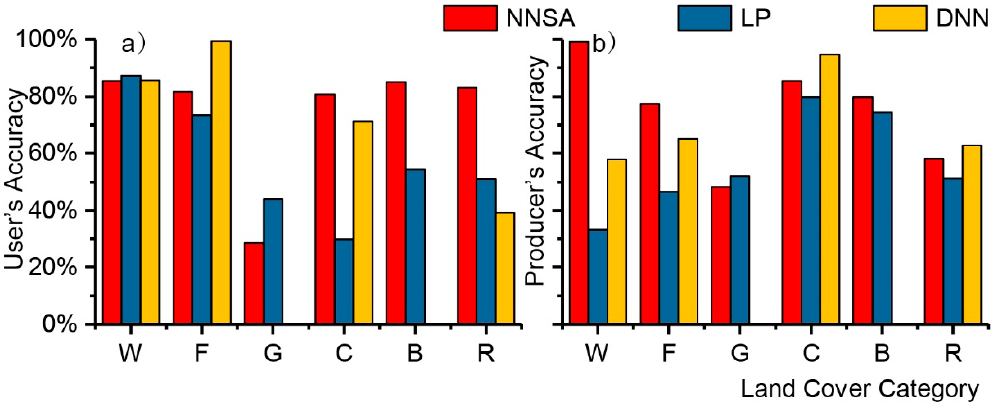
Figure 7. The accuracy assessment of sample augment results from NNSA in validation area without original samples including ( a ) user’s accuracy and ( b ) producer’s accuracy. The letters near the x -axis